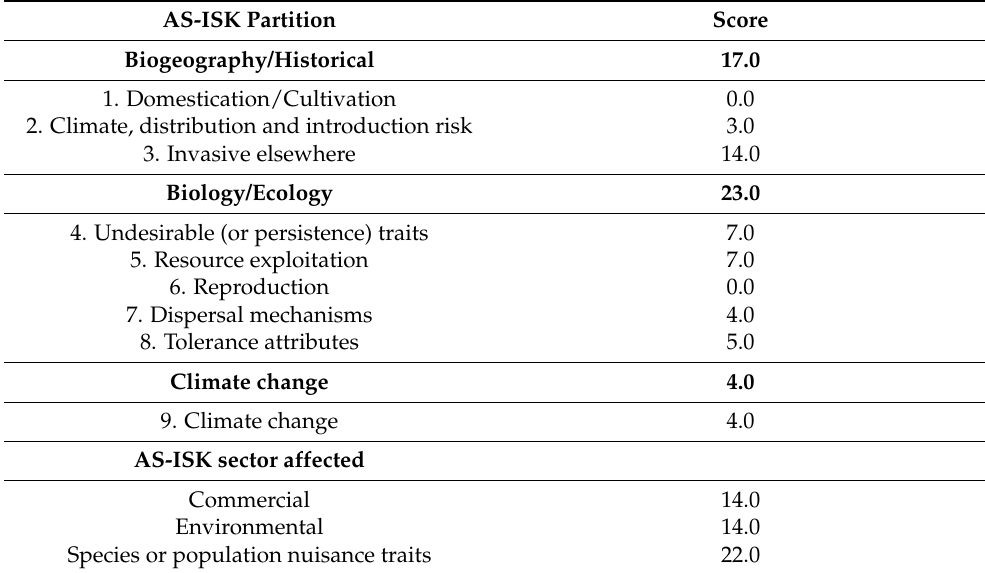
Figure 3. Score partition (in grey), BRA and BRA + CCA scores (in red) obtained applying AS-ISK for the evaluation of the invasiveness of D. villosus . BIO/HIST: Biogeography/Historical; BIO/ECO: Biology/Ecology; CLIM. CHA: Climate Change; BRA: Basic Risk Assessment; CCA: Climate Change Assessment. The colour red indicates a high level of invasiveness; the continuous line indicates the threshold between high/low level of invasiveness proposed by AS-ISK [50]. Table 3. AS-ISK statistics: score partition and sector affected.